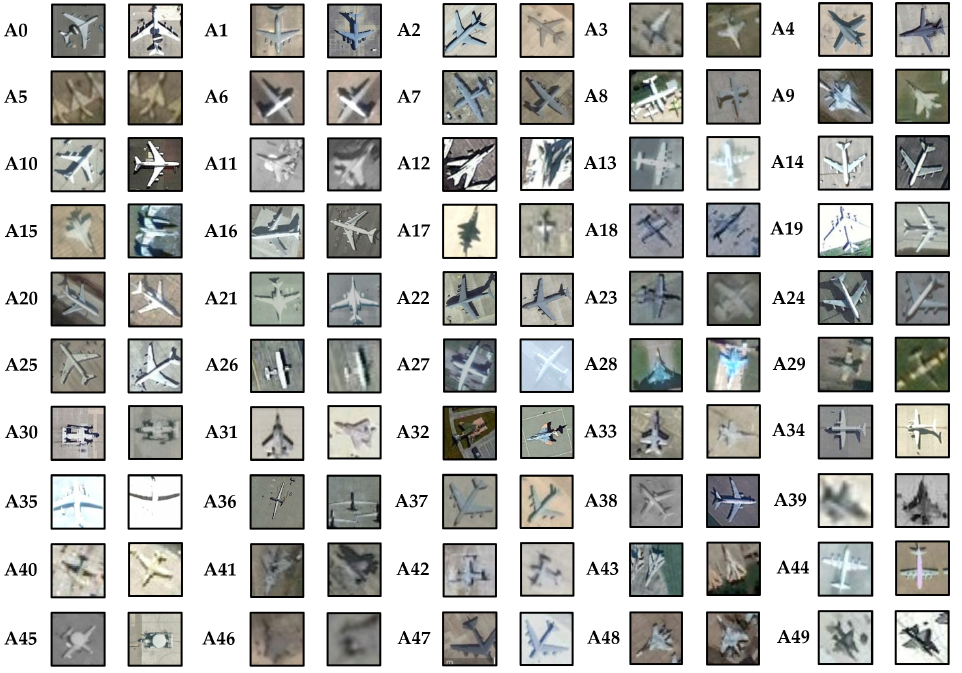
Figure 7. Examples of aircraft targets in BIT-AFGR50. Table 1. Comparisons among publicly available optical RSIC